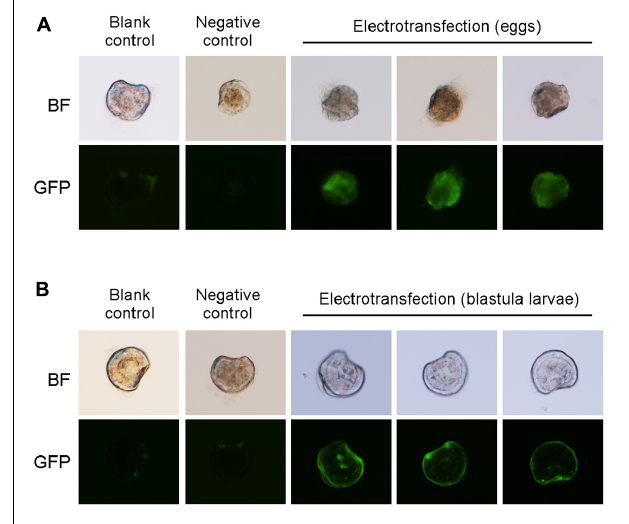
FIGURE 3 | GFP fluorescence of the D-larvae development form electroporated eggs (A) and electroporated blastula larvae (B) .